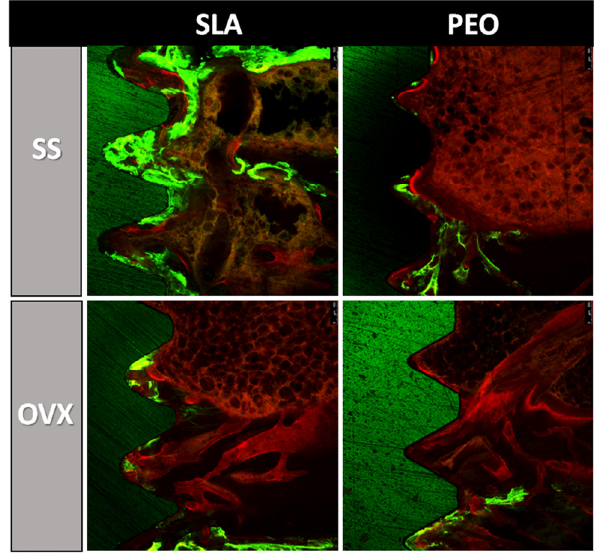
Figure 6. Photomicrographs representative of fluorochromes calcein and alizarin red through confocal microscopy for experimental groups (SS and OVX) and surface coating methods (SLA and PEO) at 60 days. Original magnification ×10.